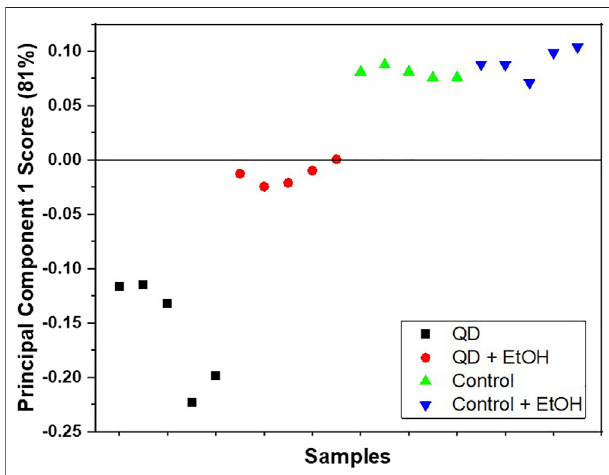
FIGURE 1 | Score plot of PC1 obtained via PCA of the positive ion TOF- SIMSspectraforthegarlicchiveleafsurfacestreatedwithQDNPs( ■ ),ethanol and QD NPs ( C ), the control ( ▲ ), and the ethanol-treated control ( ▼ ). Five data points were obtained for each surface.